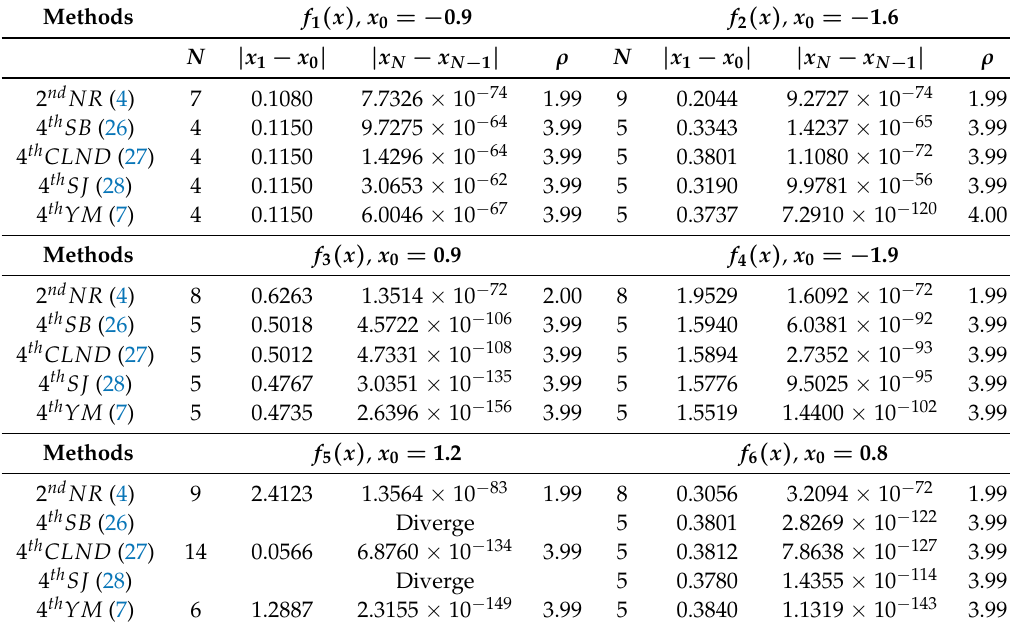
Table 2. Numerical results for nonlinear equations.